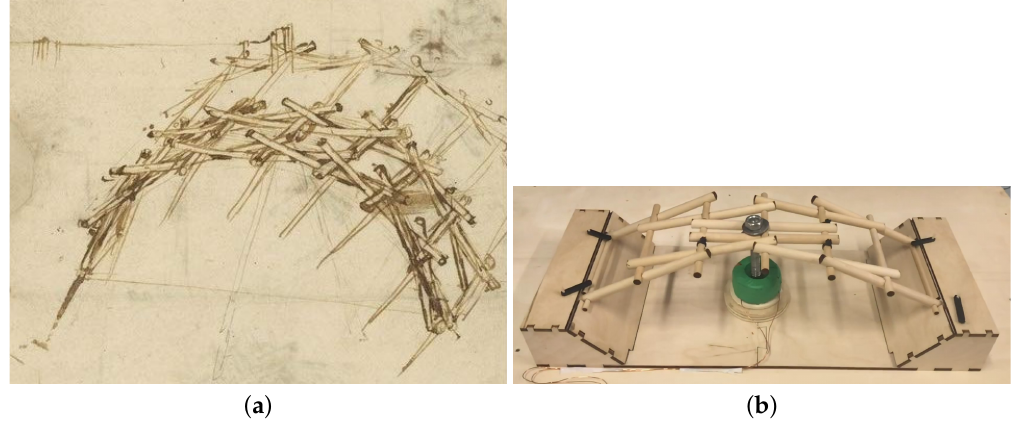
Figure 7. Machine 7, the Self-sustaining Bridge: Leonardo bridge ( a ); automated system ( b